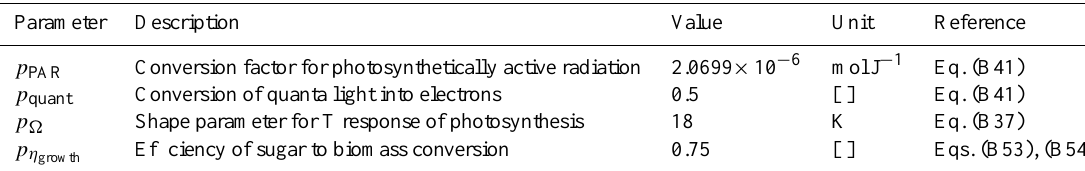
Table B11. Constant model parameters associated with lichen or bryophyte